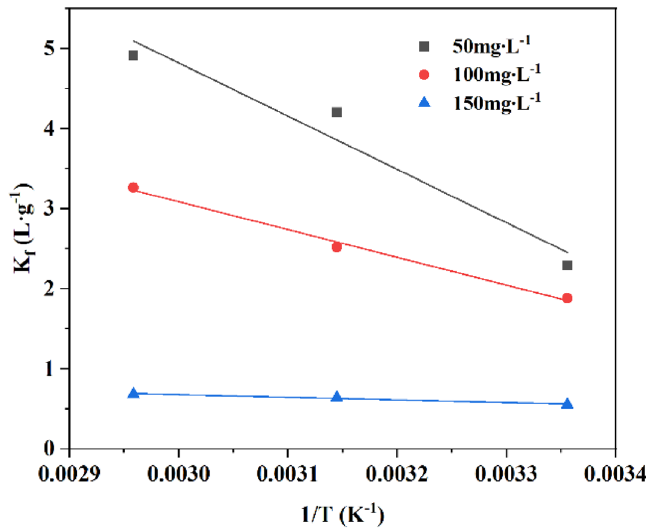
Figure 14. Thermodynamics model fitting of Cd 2+ adsorption onto MRM.